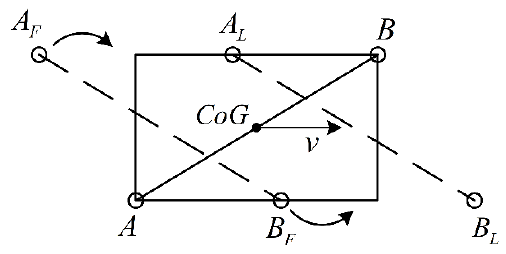
Figure 17. Trajectory of the CoG in Test 3. Figure 16. Trajectory of the CoG in Test